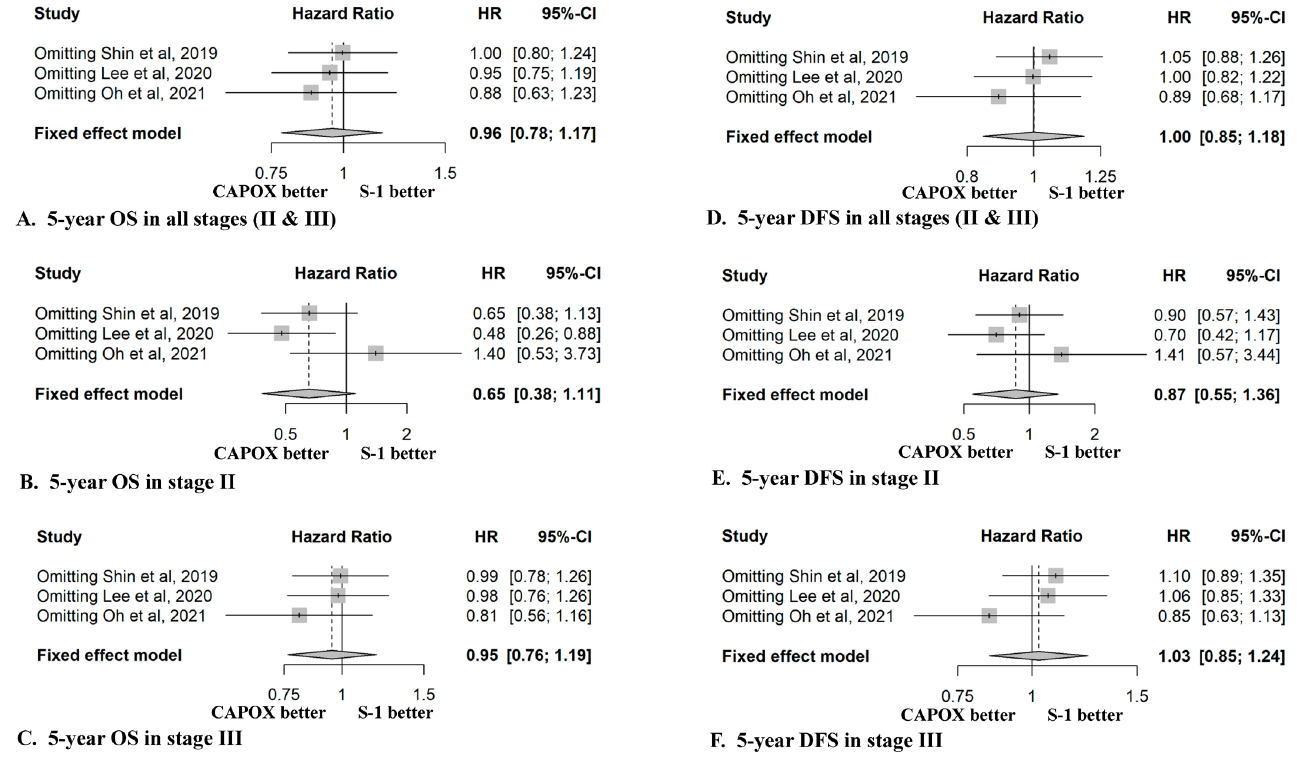
Figure 3. Sensitivity analysis of studies comparing S-1 and CAPOX as adjuvant chemotherapy in stage II or III gastric cancer. ( A ) Five-year OS in all stages (II & III), ( B ) five-year OS in stage II, ( C ) five-year OS in stage III, ( D ) five-year DFS in all stages (II & III), ( E ) five-year DFS in stage II, ( F ) five-year DFS in stage III. ( B ) S-1,tegafur/gimeracil/oteracil; CAPOX, capecitabine plus oxaliplatin; HR, hazard ratio; CI, confidence interval; OS, overall survival; DFS, diseasefree survival. Shin et al.